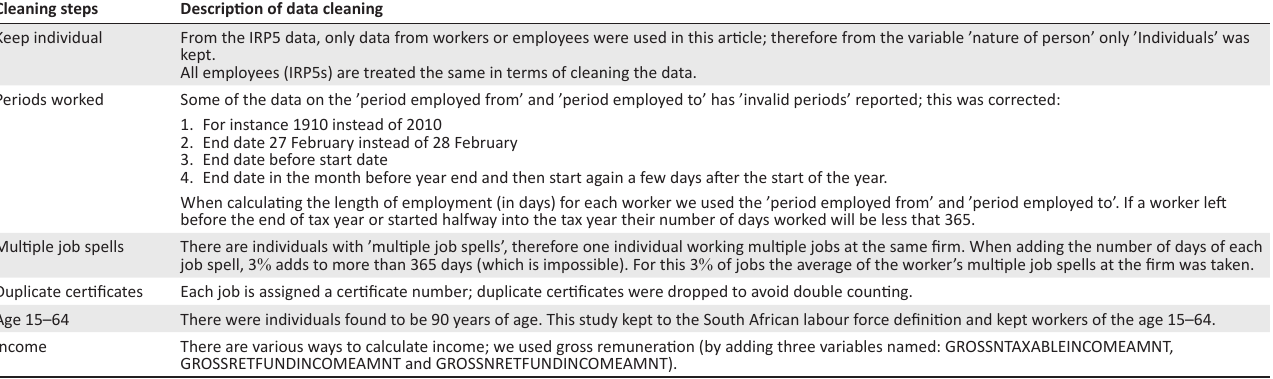
TABLE 1-A1: IRP5 data cleaning.